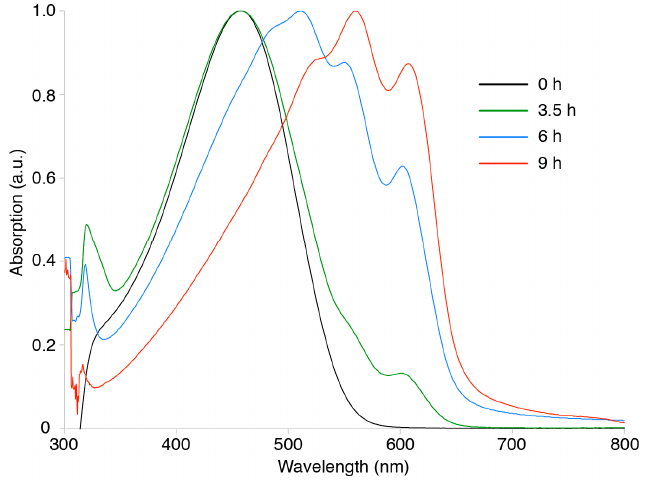
Figure 3. UV-vis absorption spectra of BCP3 in chlorobenzene/acetone (4/1, v / v ) at various time